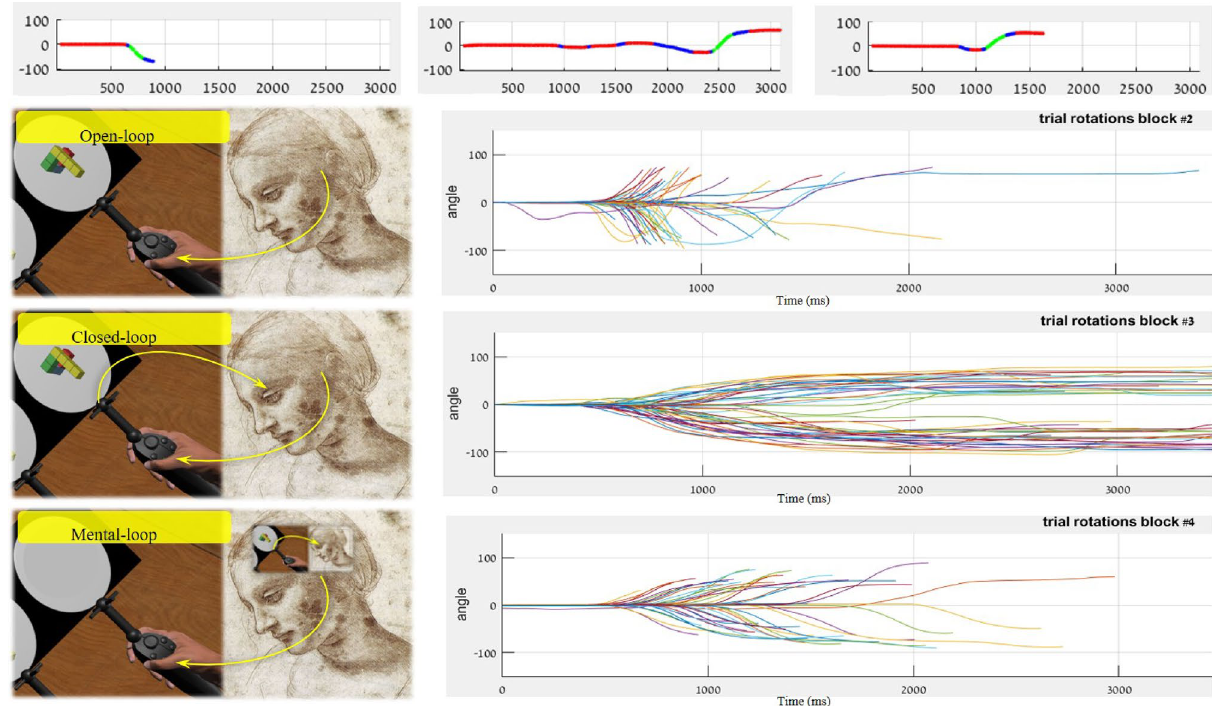
Figure 8. The motion kinematics of three representative trials and their segmentations (top) and all the trials of a single subject, shown per block. All the rotation movements, defined as the angle as a function of time, in each trial and each block, were automatically analyzed and segmented to extract the before-, during- and after- rotation durations. The segmentation of 3 trials is shown in the top plots, where green marks a rotation segment and red marks no-rotation (blue marks borderline parts). A full capture of all the trials of a single subject is shown in the 3 bottom plots. Time=0 marks the stimuli appearance. Note the differences in the motion stage durations and variability between the